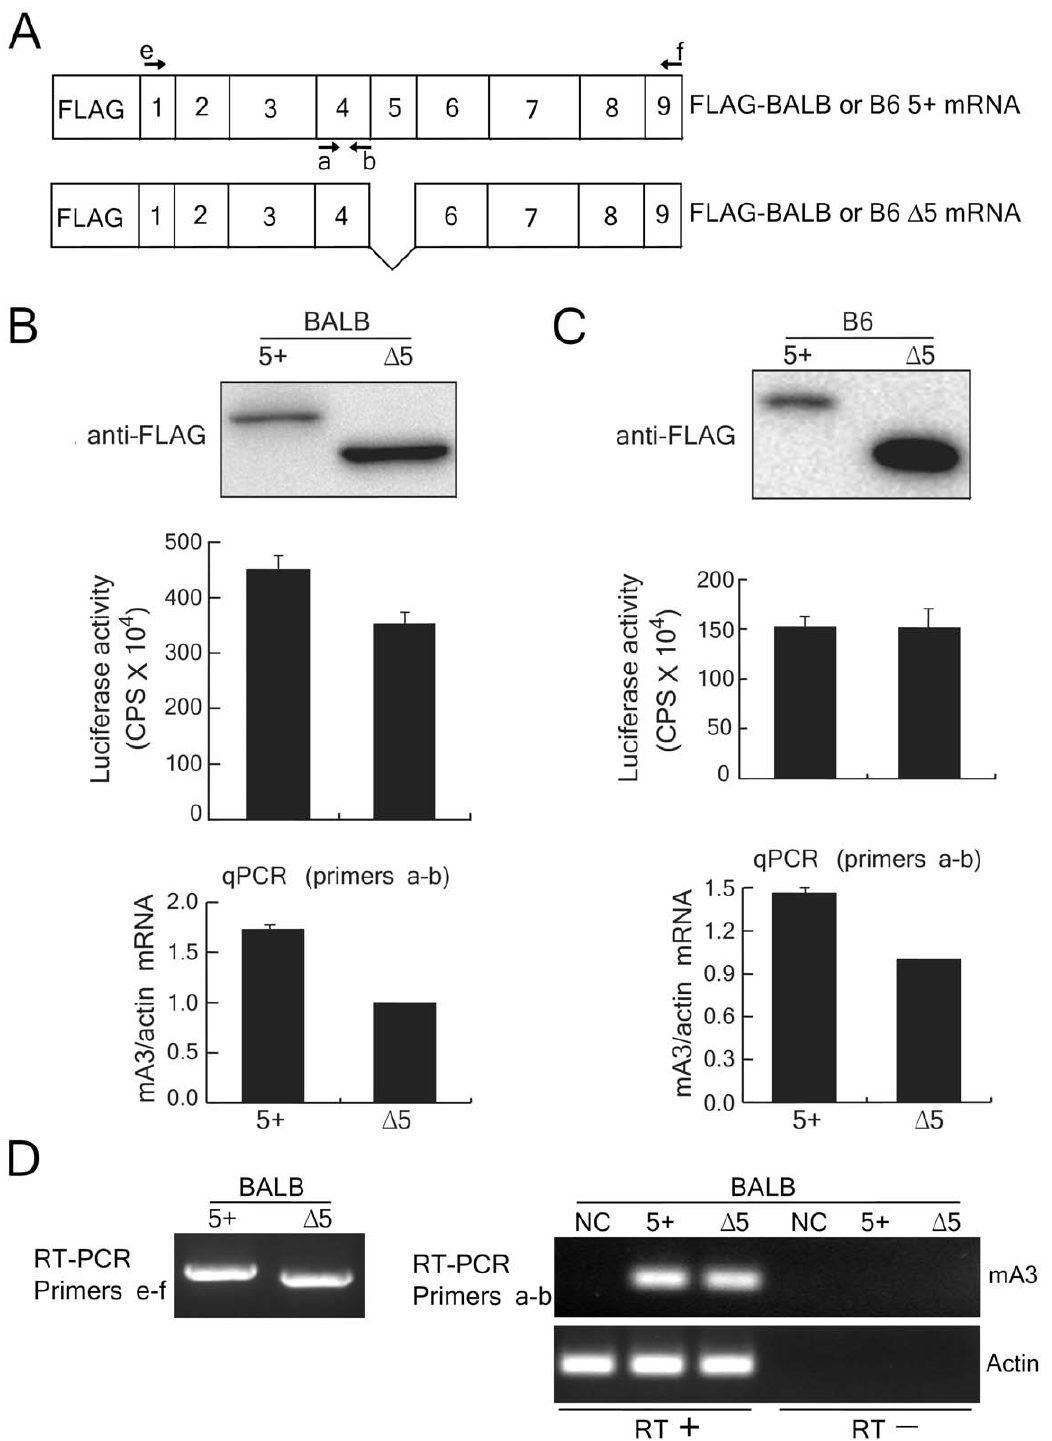
Figure 2. Protein expression of the full-length and D 5 mA3 in transiently transfected 293T cells. (A) Exon 5-containing (5 + ) and D 5 mA3 cDNA were tagged with the FLAG epitope and inserted into the expression vector. The arrows indicate the positions of the PCR primers. The primer set a-b is the same as shown in Figure 1. (B and C) 293T cells were transfected with pFLAG-CMV2- mA3 d or pFLAG-CMV2- mA3 d D 5 in B or with pFLAG- CMV2- mA3 b or pFLAG-CMV2- mA3 b D 5 in C, which express either the 5 + or D 5 mA3 cDNA cloned from BALB/c or B6 mice, respectively [27]. A luciferase-expressing plasmid, p luc , was co-transfected to standardize transfection efficiencies. At 24 hours after transfection, each one-third of the transfected cells was used for immunoblotting, RNA extraction, and luciferase assays. For immunoblotting, the full-length and D 5 mA3 proteins were detected with the anti-FLAG antibody. Quantitative real-time PCR reactions were carried out with primer set a-b and were normalized with the levels of actin transcripts expressed in 293T cells. Data shown are averages of three reaction wells and SD. (D) RT-PCR assays were performed with (RT + ) or without (RT 2 ) reverse transcription to demonstrate specific detection of expected mRNA. Both primer sets e-f and a-b were used to detect mA3 mRNA. NC, negative control transfected with the empty vector, pFLAG-CMV2. RT– samples were included to evaluate the possible contamination of transfected DNA. Specific amplification of cDNA generated in the presence of RT was observed in the cells transfected with a plasmid expressing the 5 + or D 5 mA3 cDNA. Similar results were obtained for the corresponding B6-derived cDNA clones. doi:10.1371/journal.ppat.1002478.g002 PLoS Pathogens |